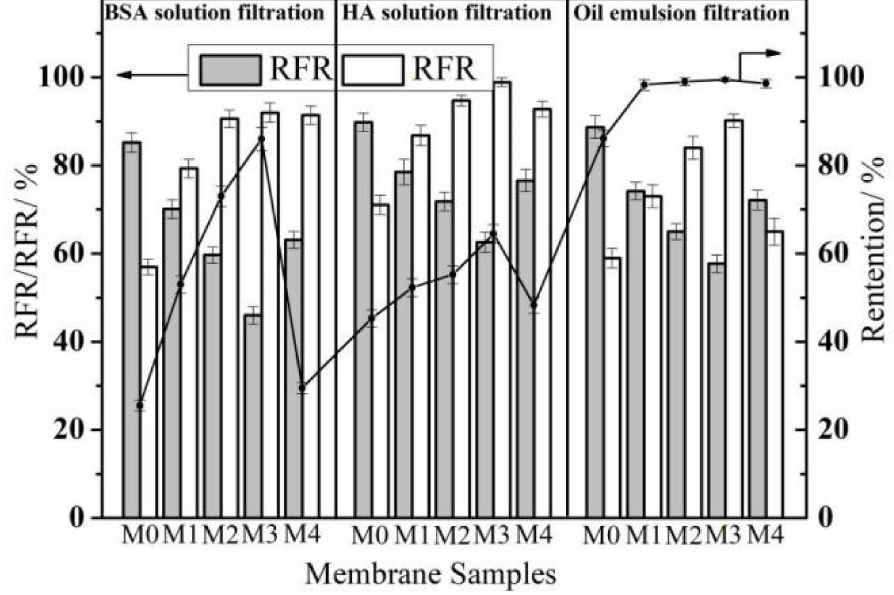
Figure 7. The relative flux decay (RFD), the relative flux recovery (RFR), and the retention rate (R) from the filtration of BSA solution, HA solution, and oil